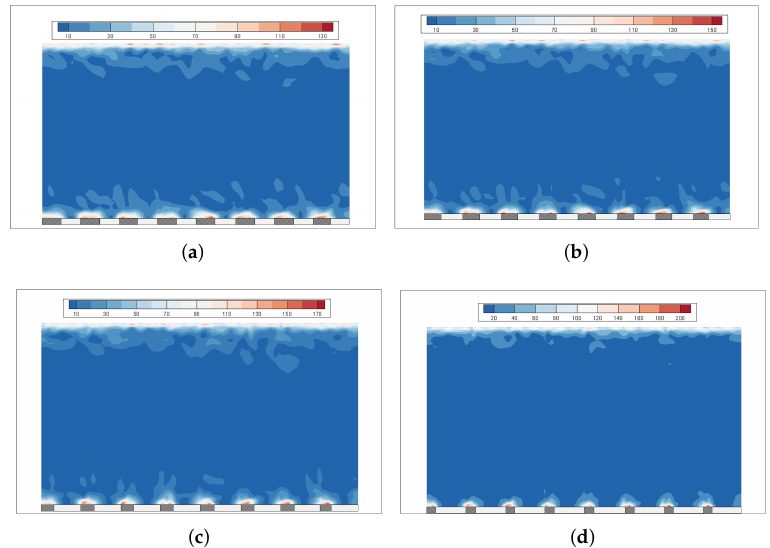
Figure 12. Comparison of vorticity for different GF at Strip number = 8. ( a ) GF = 0.5. ( b ) GF = 0.6. ( c ) GF = 0.7 ( d ) GF =